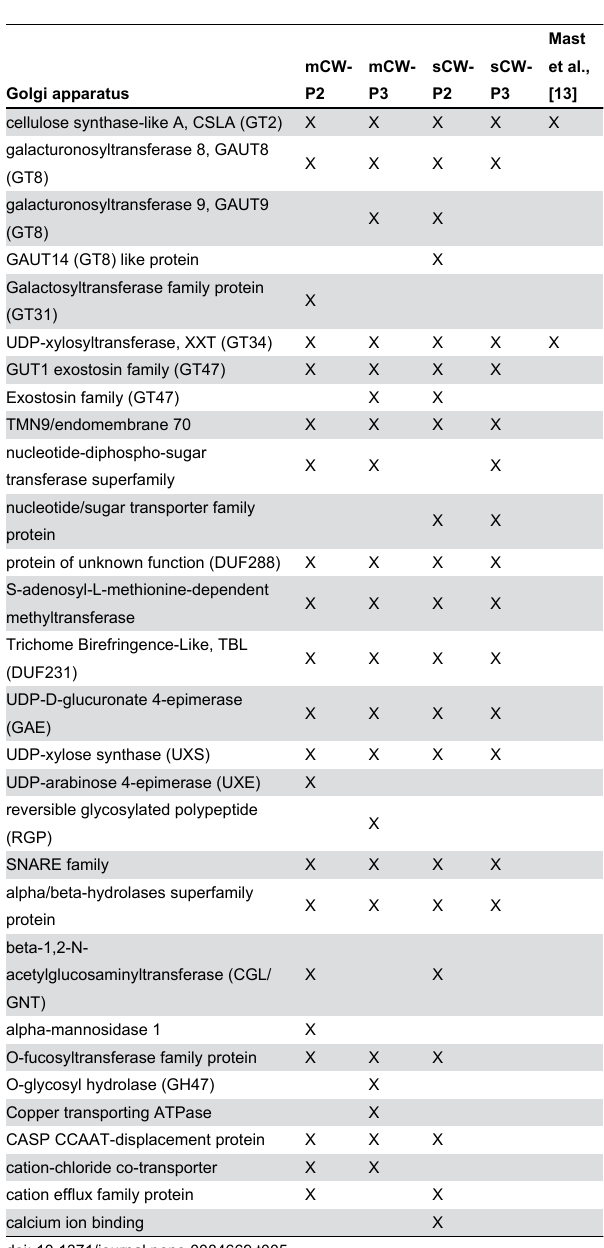
Table 5. Golgi localized proteins identified from samples mCW and sCW harvested from developing xylem of pine.